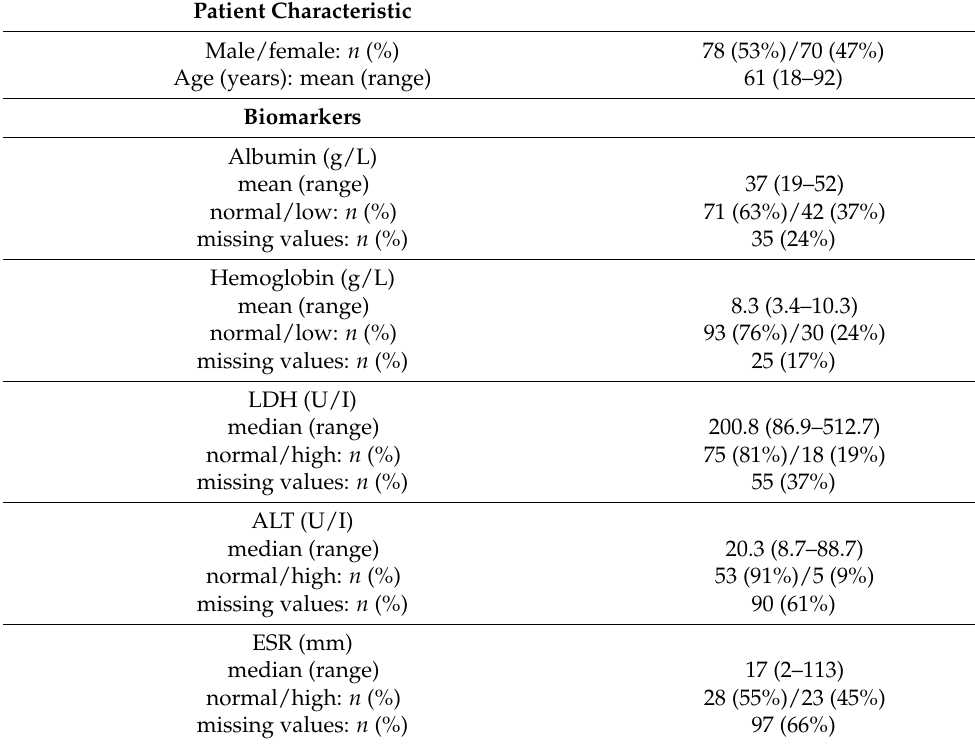
Table 1. Patient